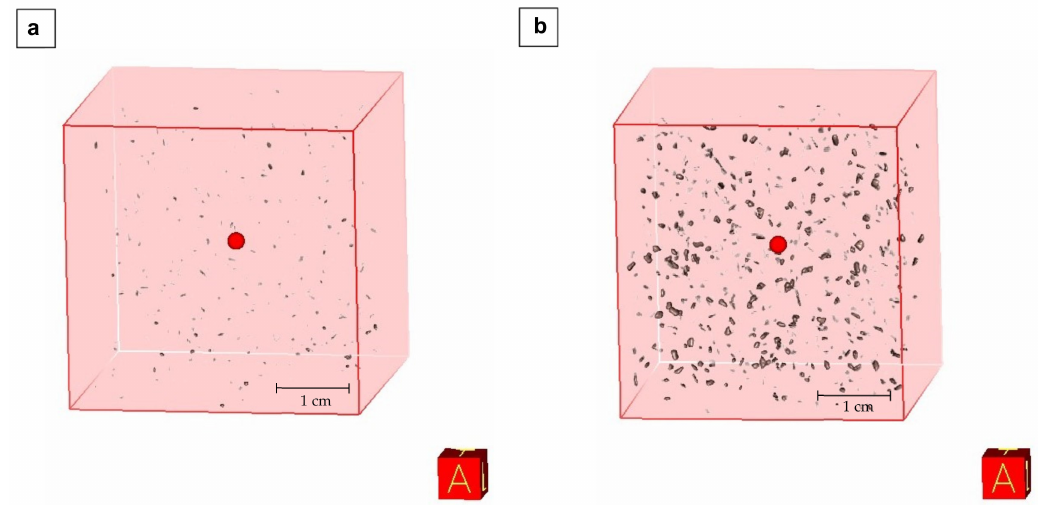
Figure 5. Computer tomography images of filler distribution and agglomeration in PUR-WP